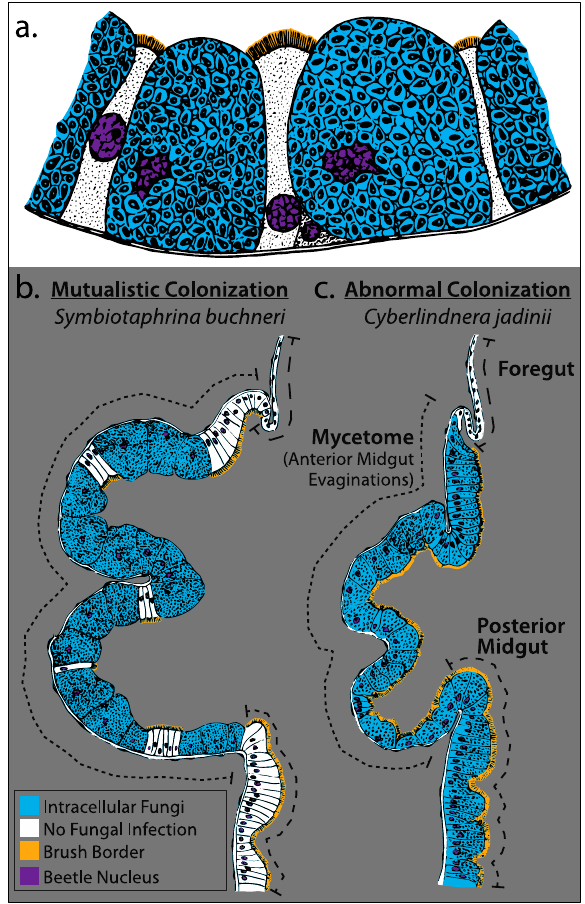
Figure 4. Cellular structure of the infection by fungi and in the midgut mycetome of St. paniceum . Within the mycetome, mycetocytes harbor intracellular Symbiotaphrina cells and lack a brush border, while pillar cells are not infected with fungi and retain a brush border ( a ). Intracellular infection of the mycetomes within the midgut evaginations of St. paniceum with its mutualistic partner— Sy. buchneri ( b ); and the free-living Saccharomyces— Cy. jadinii ( c ). In a mutualistic colonization, the intracellular fungi are restricted to the mycetome, whereas in the abnormal colonization by Cy. Jadinii , the intracellular fungi are found in midgut cells outside the mycetome. Figure adapted from Breitsprecher (1928) [42], Buchner (1965) [38], and Foeckler (1961) [103]. Electron microscopy surveys of mycetome ultrastructure in L. serricorne show that Symbiotaphrina are mostly located in basal regions of mycetocytes where the majority of fungal cells are viable, while cells appear to decrease in abundance and become lysed in the apical area (toward the gut lumen) [33,104]. These observations suggest that digestion of the symbiont may play a large